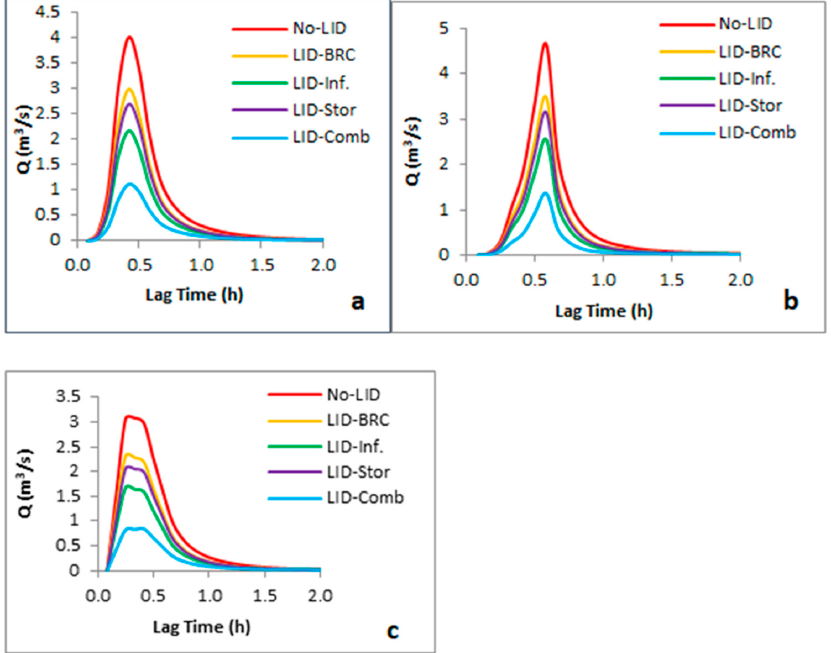
Figure 7. Impact of LID techniques on runoff generated from a 30 min rainfall duration of rainfall patterns: ( a ) TS1 (r = 0.4–0.6); ( b ) TS2 (r = 0.8–1) and ( c ) TS3 (r = 0–0.2).